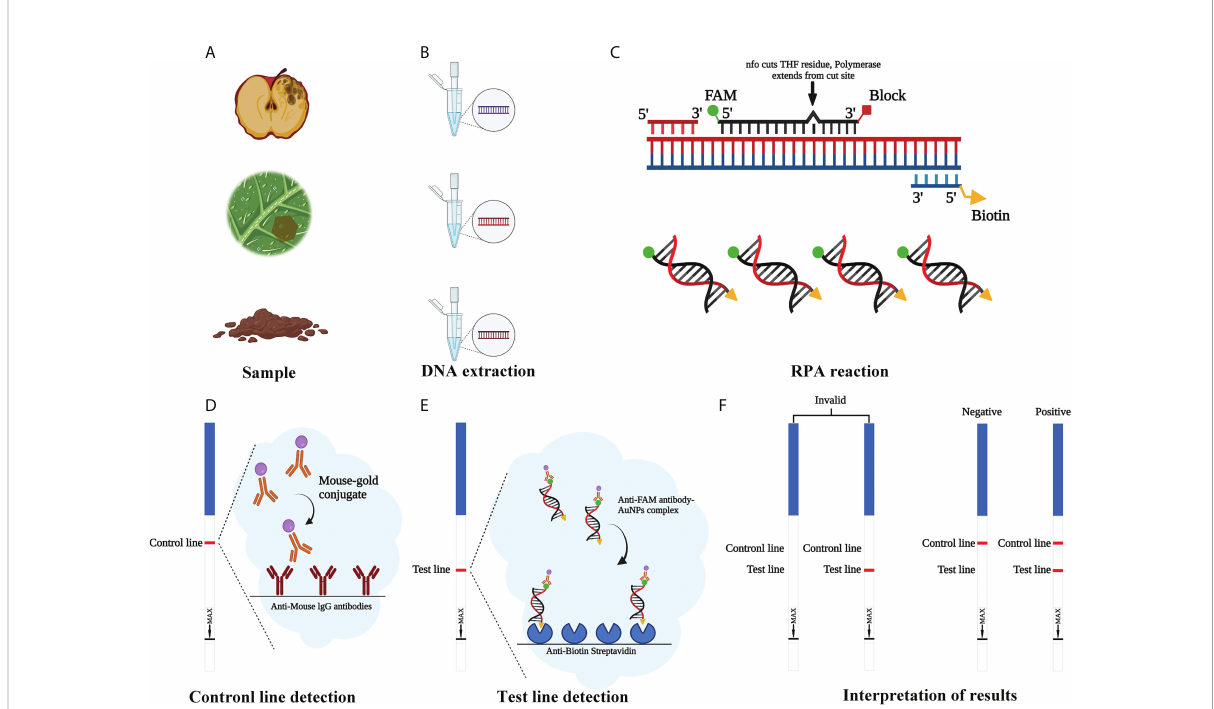
FIGURE 1 Schematic illustration of the RPA-LFD assay used to detect Phytophthora cinnamomi. (A) Collect the samples. (B) Genomic DNA (gDNA) is extracted from samples using the NaOH method. (C) Recombinase polymerase ampli fi cation (RPA). (D) Mouse antibody-gold conjugate binds to immobilized anti-mouse IgG antibodies. (E) The sample enters testing line and anti-FAM antibody-AuNPs complex binds to immobilized anti- biotin streptavidin. (F) Invalid result: no visible dipstick in control line despite the test line. Positive result: one visible dipstick each in control line and test line. Negative result: one visible dipstick in control line. Created with